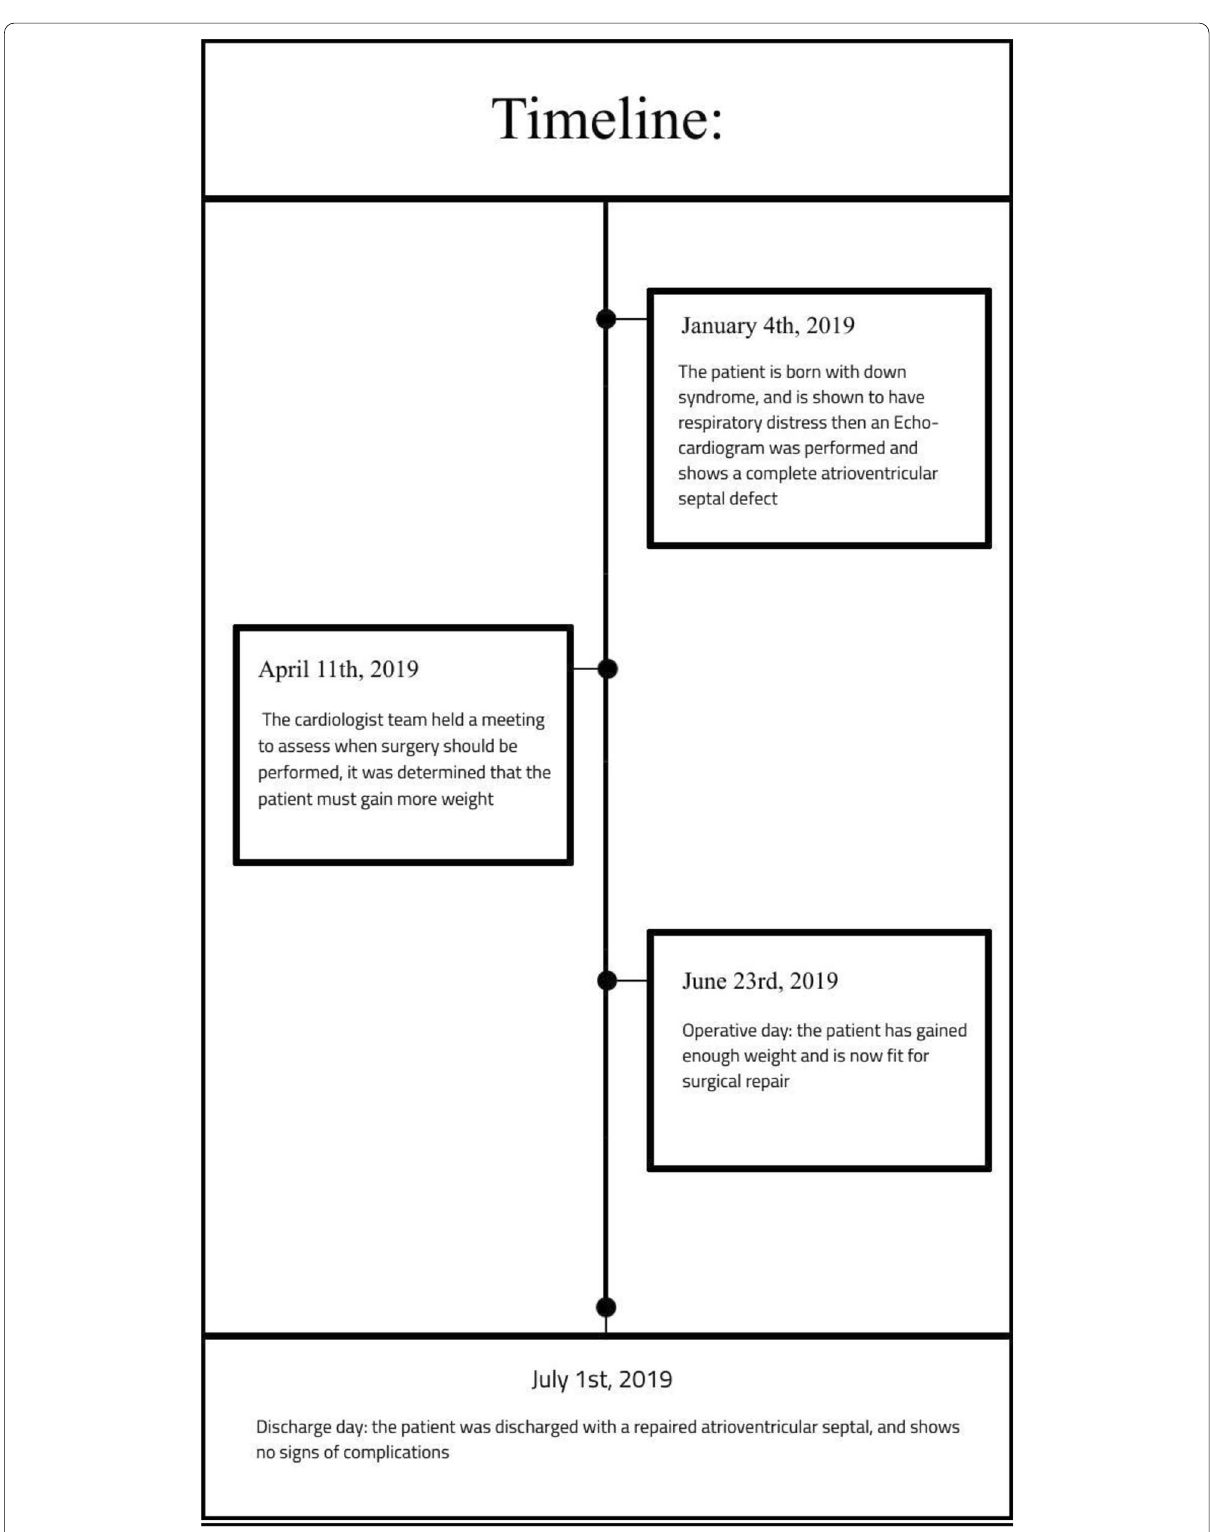
Fig. 5 Timeline of the patient’s birth to their discharge after the Complete Atrioventricular Canal